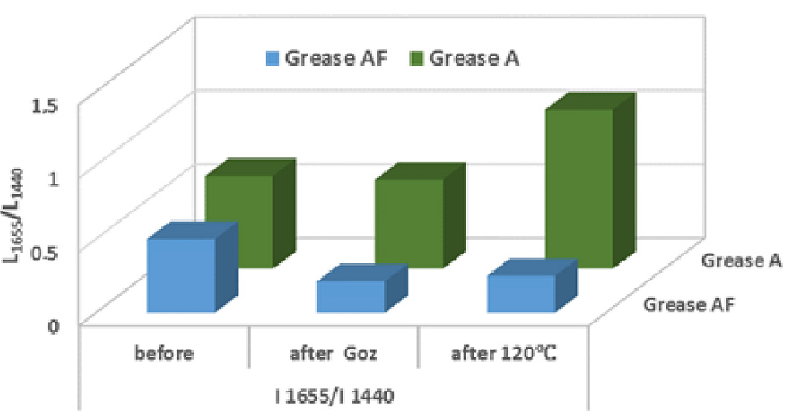
Figure 5. The influence of thermo-oxidation (Petrooxy) and mechanical forces (G oz ) on the change of ratio of intensity integral unsaturated bonds C=C to the saturated bonds C-C of greases: vegetable Grease A and vegetable-mineral Grease AF.